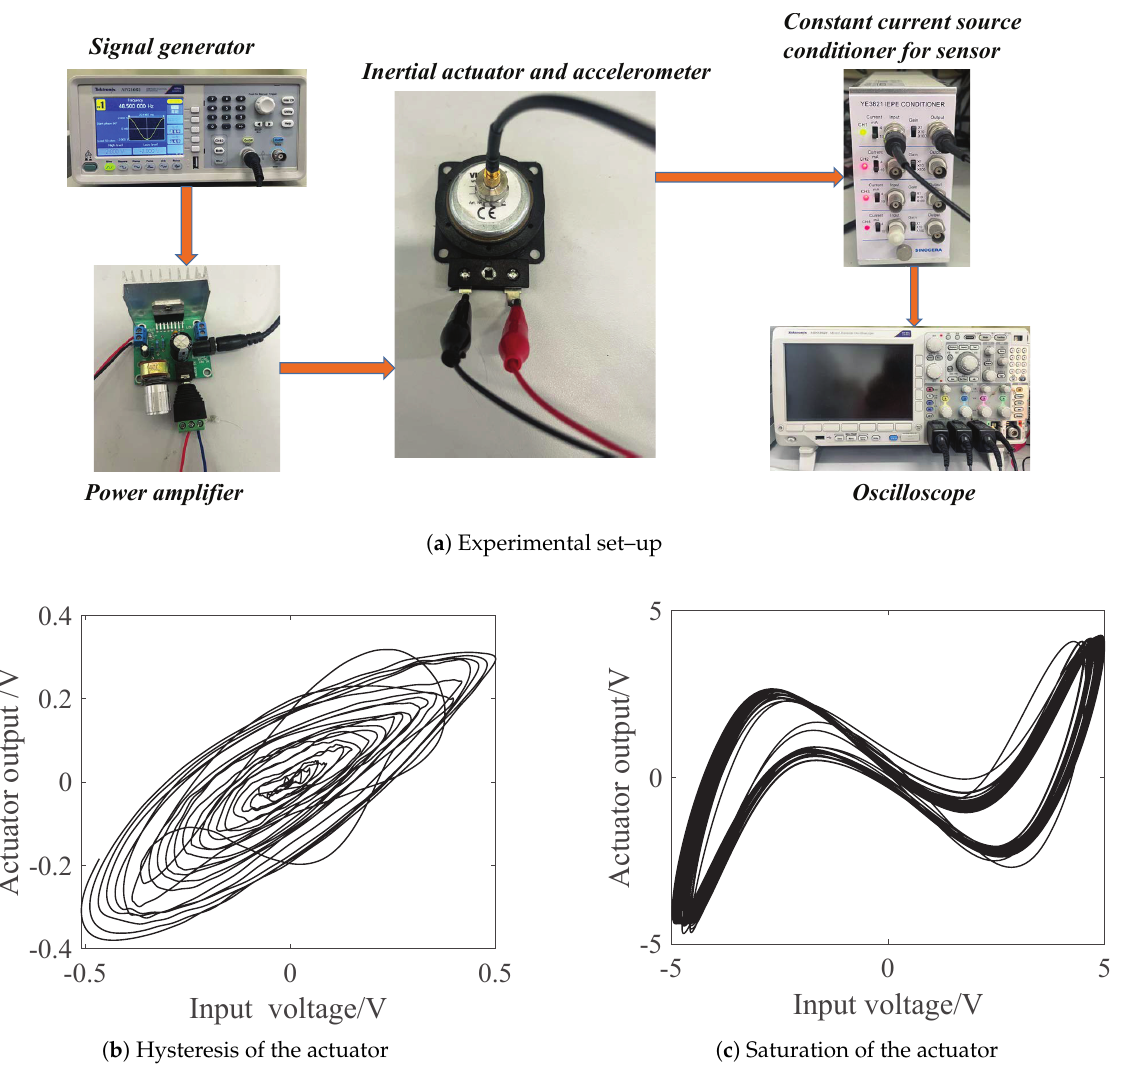
Figure 2. Experimental research on system